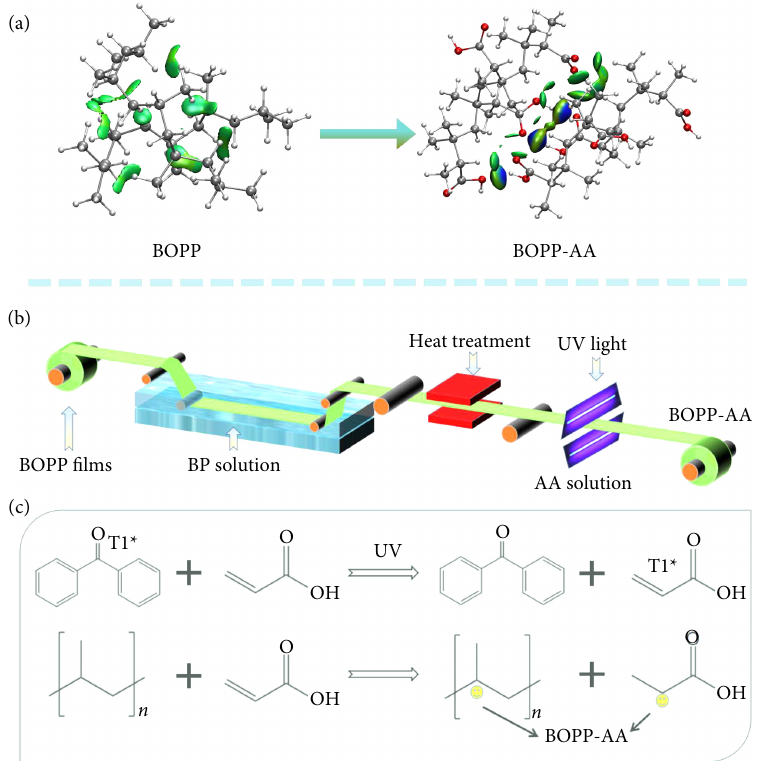
Fig. 1 (a) IGM simulation of BOPP and BOPP–AA. (b) Schematic diagram of the grafting process. (c) Molecular reaction formula during the grafting